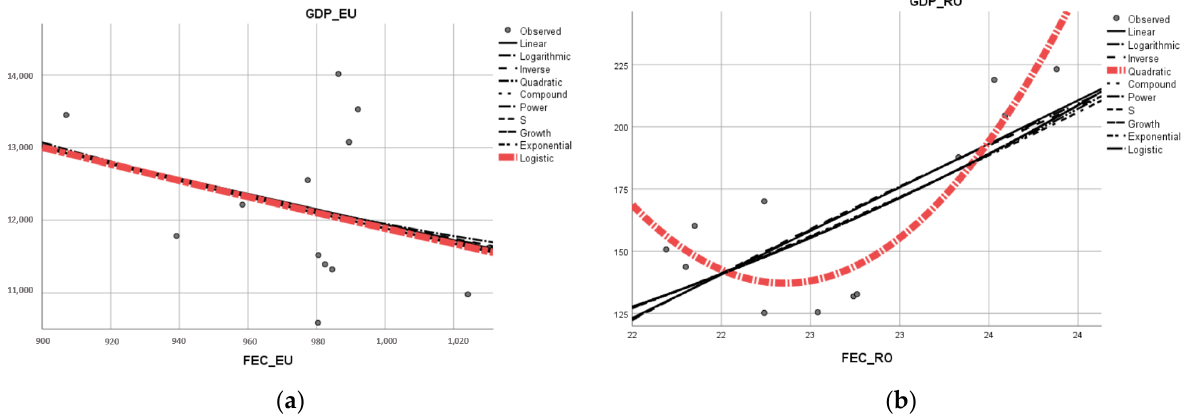
Figure 5. The curve estimation regression models of GDP as a function of FEC (2009–2020): ( a ) EU; ( b ) RO.